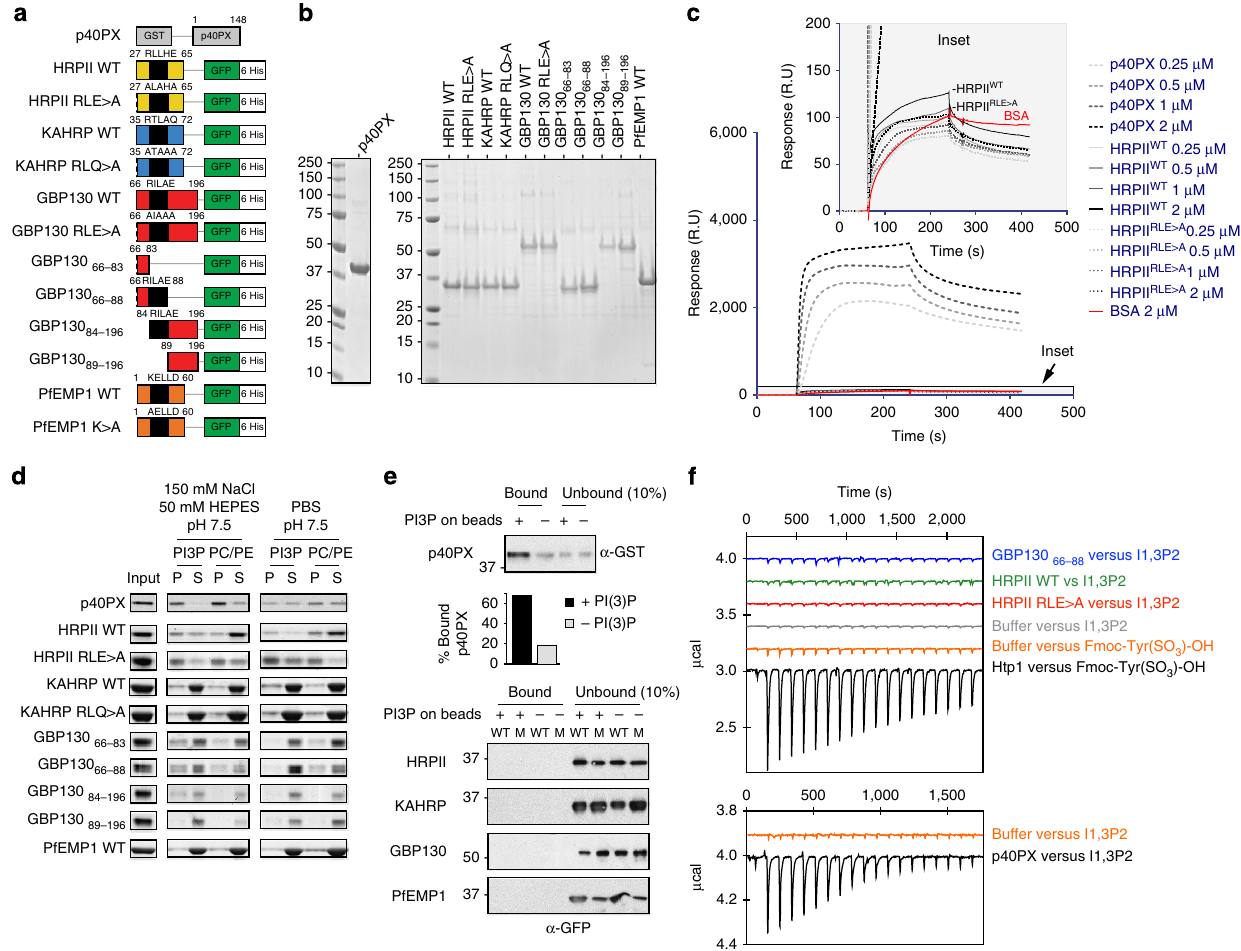
Figure 1 | Exported P. falciparum proteins do not bind PI(3)P. ( a ) Recombinant proteins expressed in this study as fusions to GST or GFP/6His. ( b ) Recombinant proteins stained with Coomassie blue stain. Molecular weights (kDa) are shown. ( c ) Binding of p40PX and HRPII with native PEXEL (WT) or mutant PEXEL (RLE 4 A) to PI(3)P liposomes measured by SPR. Binding to control PC/PE liposomes was subtracted to give the sensorgrams 24 . BSA was used to measure nonspecific binding to the liposome-coated chip (red). Inset: a similar level of low binding of HRPII WT and HRPII RLE 4 A to PI(3)P liposomes. Experiments were performed in triplicate. ( d ) Binding of proteins to PI(3)P liposomes or control PC/PE liposomes, determined by ultracentrifugation. Pellet and supernatant fractions were resolved by SDS–PAGE and Coomassie blue stain. Proteins were ultracentrifuged in buffer to remove potential aggregates before incubation with liposomes 39 , explaining why input and sum of pellet and supernatant sometimes differ. Experiments were performed in triplicate. Full-length gels shown in Supplementary Fig. 6. ( e ) Binding of p40PX and P. falciparum proteins with native PEXEL (WT) or mutant PEXEL (M) to PI(3)P-coated beads ( þ ) or control beads lacking lipid ( (cid:2) ). Bound protein was eluted in SDS–PAGE sample buffer and detected by immunoblot with anti-GST (p40PX) or anti-GFP ( P. falciparum proteins). Ten per cent of unbound fraction volume was loaded to visualize protein inputs. Densitometry (histogram shown) of the p40PX bands shows that 68% of p40PX input bound to PI(3)P-coated beads (PI3P þ ) compared with 18% of input to control beads (PI3P (cid:2) ). No binding was detected for P. falciparum exported proteins. Experiments were performed in triplicate. Full-length gels shown in Supplementary Fig. 7. ( f ) Binding of recombinant proteins to phospholipid head group of PI(3)P (inositol 1,3 bisphosphate; I1,3P2) in solution, measured by isothermal calorimetry. The titration did not differ between I1,3P2 (2.4mM) into dialysis buffer (150mM NaCl, 20mM HEPES pH 7.4) (negative control) and the same buffer containing either GBP130 66–88 , HRPII WT or HRPII RLE 4 A . As controls, binding of Htp1 from S. parasitica to Fmoc-Tyr(SO 3 )-OH and also p40PX binding to I1,3P2 are shown. Experiments were performed in